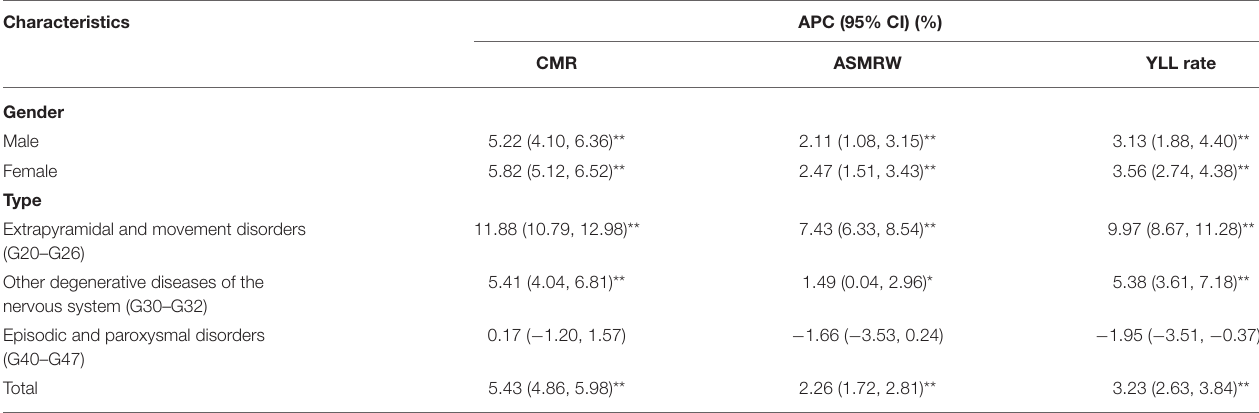
TABLE 3 | Trends of CMR, ASMRW, and YLL rate of selected neurological disorders in genders and major types during 1995–2018. Characteristics